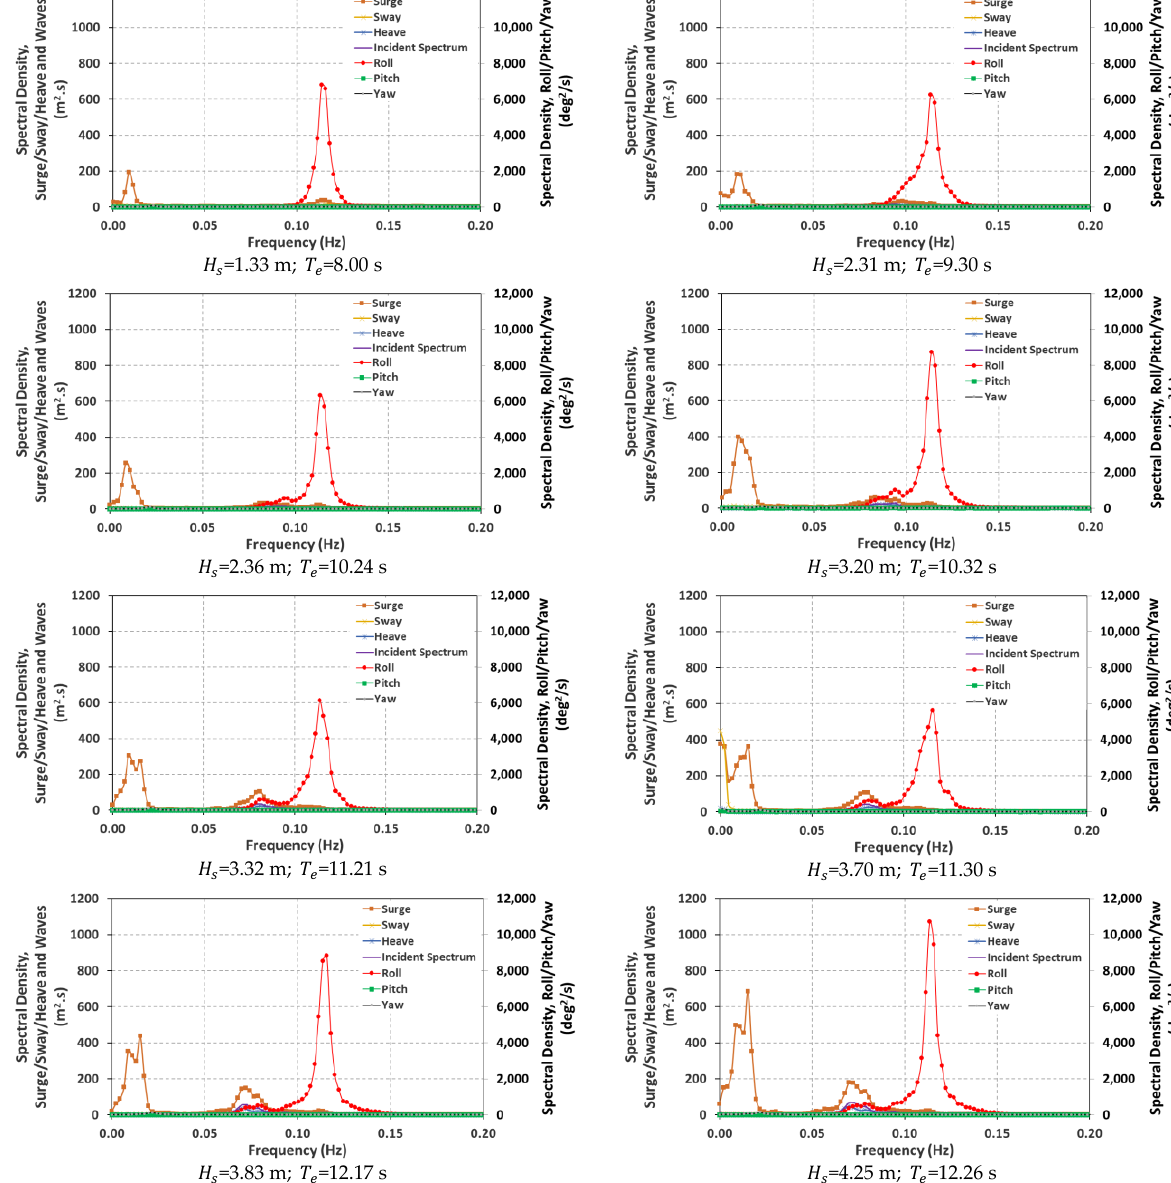
Figure 9. Hydrodynamic roll response for the six DoFs, concerning the HC V1 model.